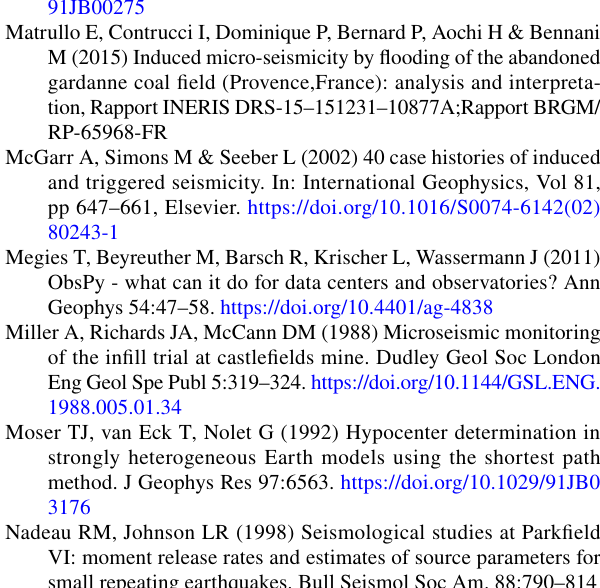
VI: moment release rates and estimates of source parameters for small repeating earthquakes. Bull Seismol Soc Am.